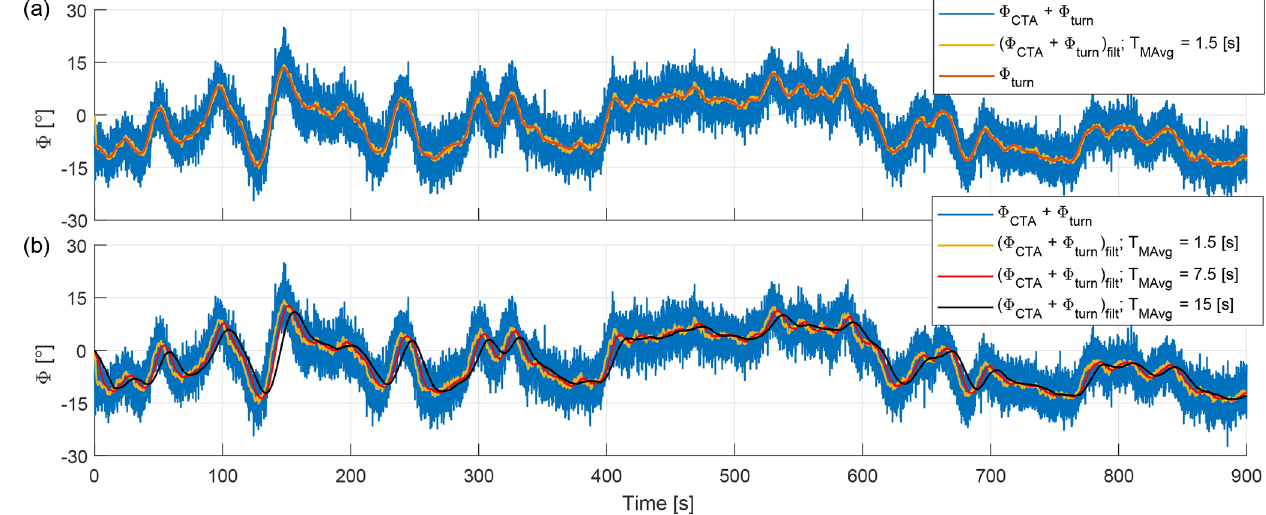
Figure 6. (a) Time history of the combined wind direction changes experienced by the farm (blue), its 1.5s moving average (orange), and the measured turntable rotation (red). (b) Effect of the increasing time-averaging window T MAvg on the wind direction time series. Table 1. FLORIS parameters calibrated according to Campagnolo et al. (2019). α β k a k b TI a TI b TI c TI d 0 . 9523 0 . 2617 0 . 0892 0 . 027 0 . 082 0 . 608 − 0 . 551 − 0 .